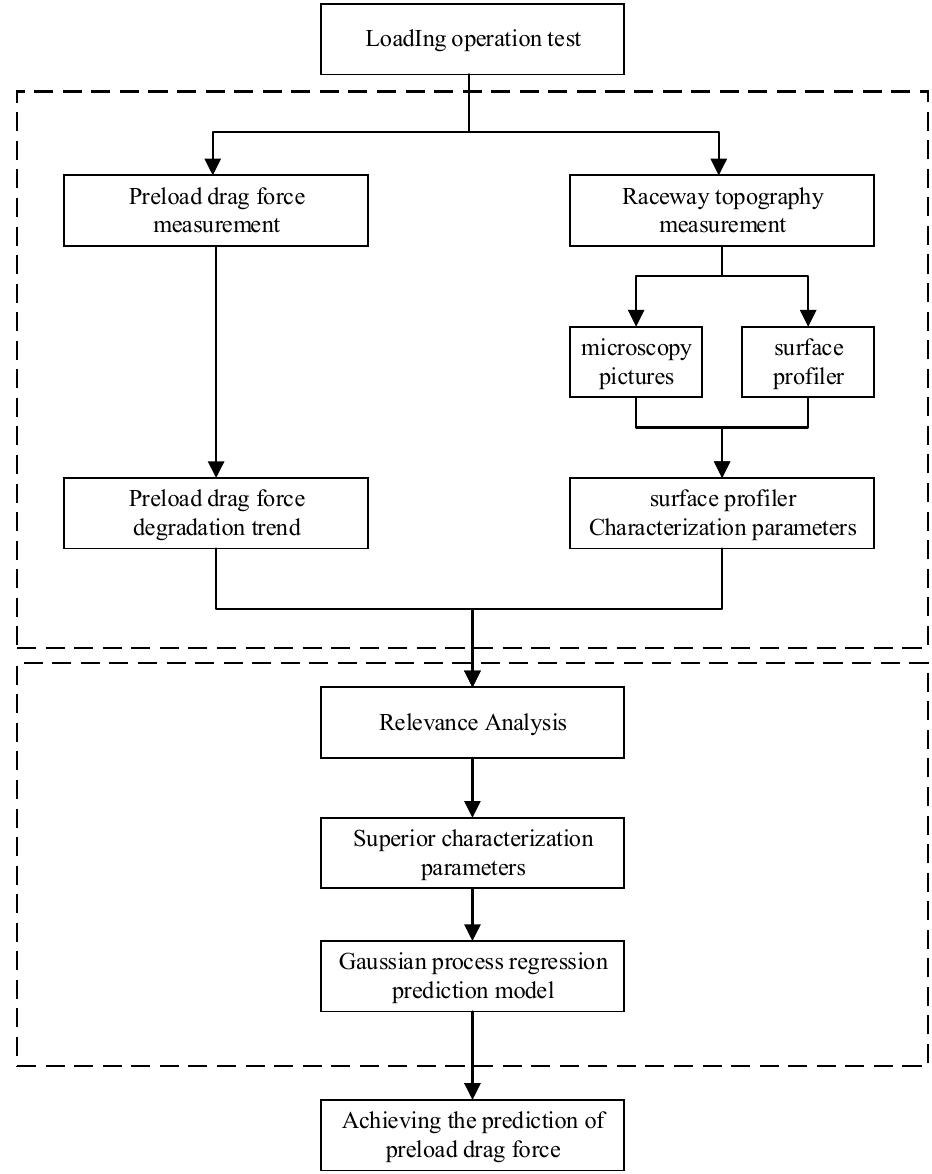
Figure 1. The structure diagram of this research.